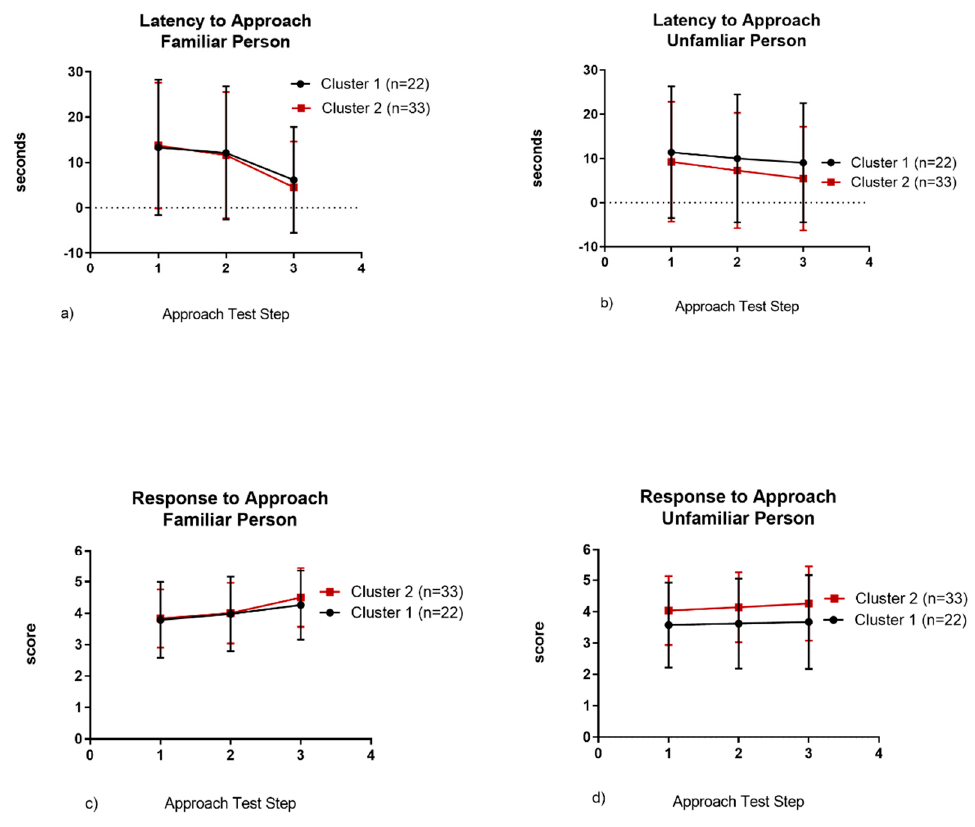
Figure 4. Latency to approach a familiar person ( a ) or unfamiliar person ( b ) and response to approach of a familiar ( c ) or unfamiliar person ( d ).